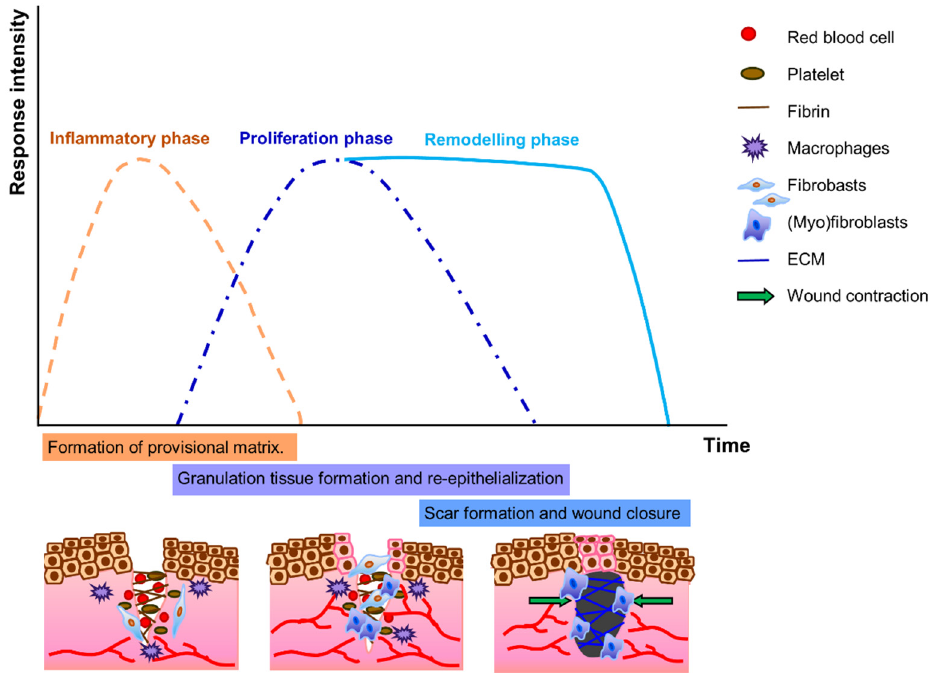
Figure 2. Wound healing phases. In the inflammatory phase, fibroblasts synthesize a provisional matrix consisting of fibrin. Platelets release multiple chemokines that recruit inflammatory cells, including macrophages, as well as fibroblasts. In the proliferation phase, a new capillary network develops and contributes to the proliferation of fibroblasts. Fibroblasts are transient to (myo)fibroblasts, which encourages the synthesis of ECM for maturation of granulation tissue. During the remodeling phase, scar tissue is formed by ECM remodeling, replacement of collagen III by collagen I, and an increase in elastin in the tissue. (Myo)fibroblasts contract the scar tissue and the wound is closed.